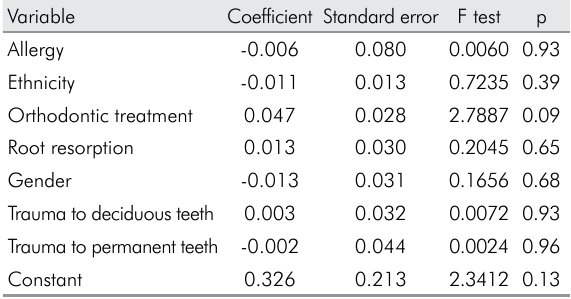
Table 1. Multivariate regression analysis of anti-dentine SIgA secretion rate and study